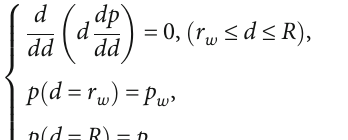
Figure 2: Stress state of a borehole under a nonuniform pore pressure